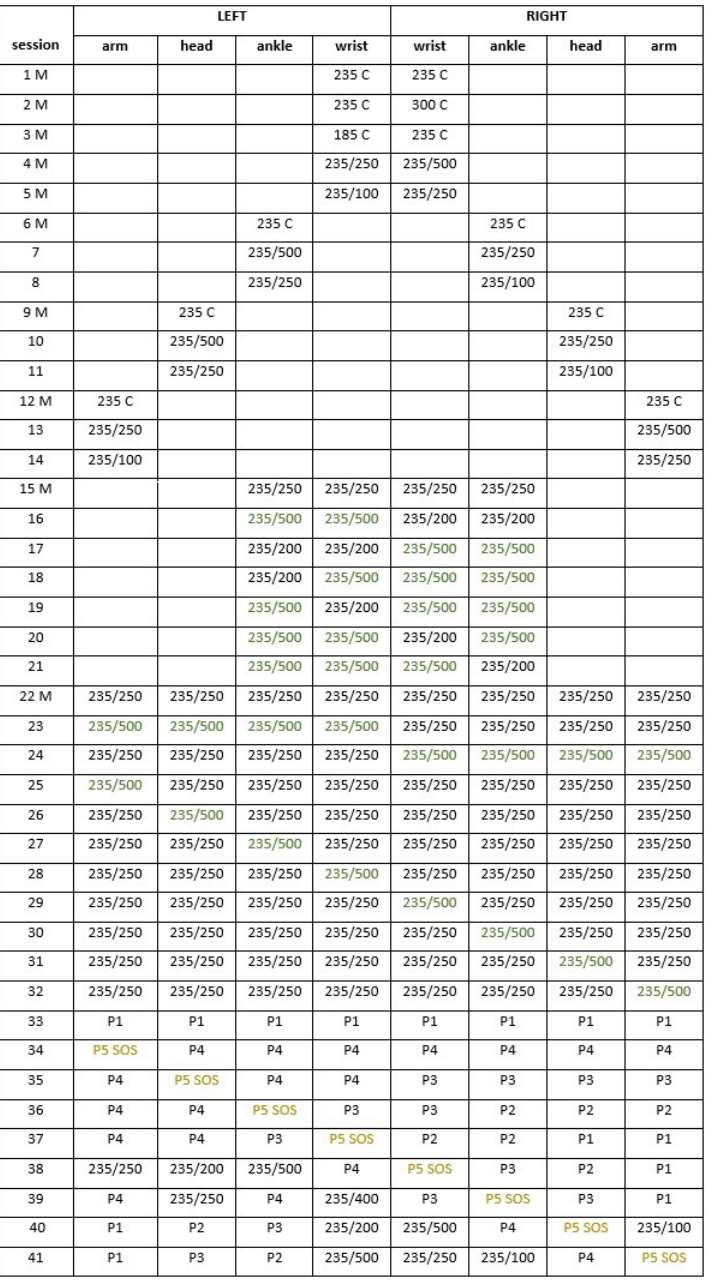
Figure 7. All sessions used in the experiment. M denotes mandatory sessions and C is for continuous signal. The first number in each cell corresponds to the frequency, followed by the length of the bursts and pauses in milliseconds. Colored characters help orientation in the table by highlighting the same signal. In sessions 33 to 41, P1 to P5 are the patterns based on Figure